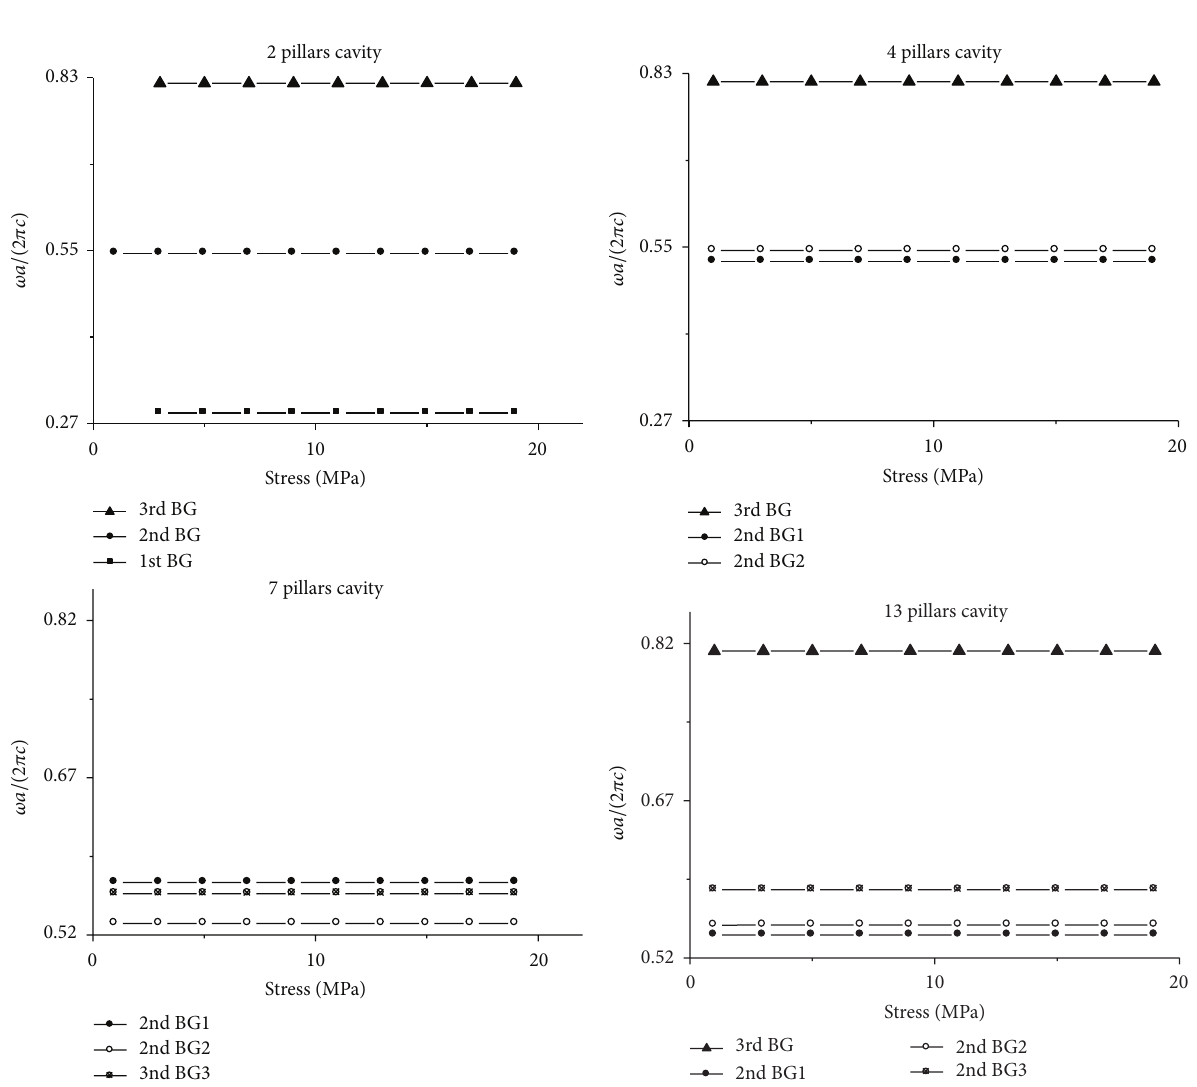
Figure 14: The resonant frequency change with stress on 𝑥 direction for 𝑛 pillars cavity. The four figures are the result for 2, 4, 7, 13 pillars cavity, respectively. The square, circle, and triangle legends represent the curves which are localized in the first, the second, and the third band gap,